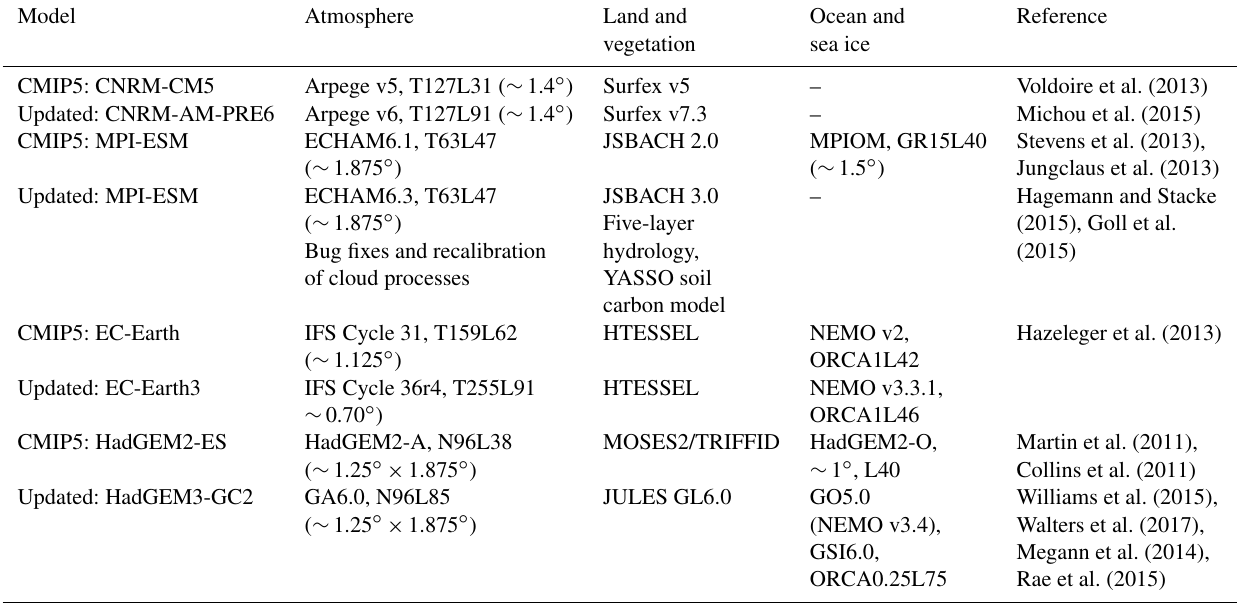
Table 1. List of models analyzed.